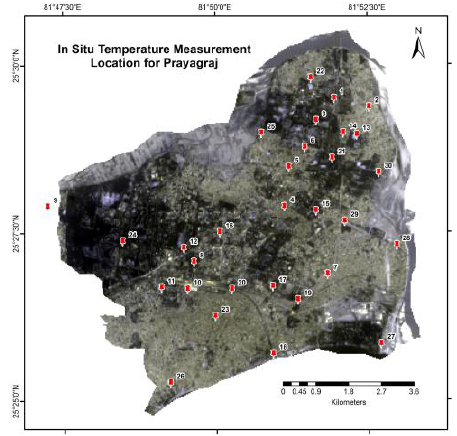
Figure 2. Distribution of locations in Prayagraj for in-situ temperature measurement at